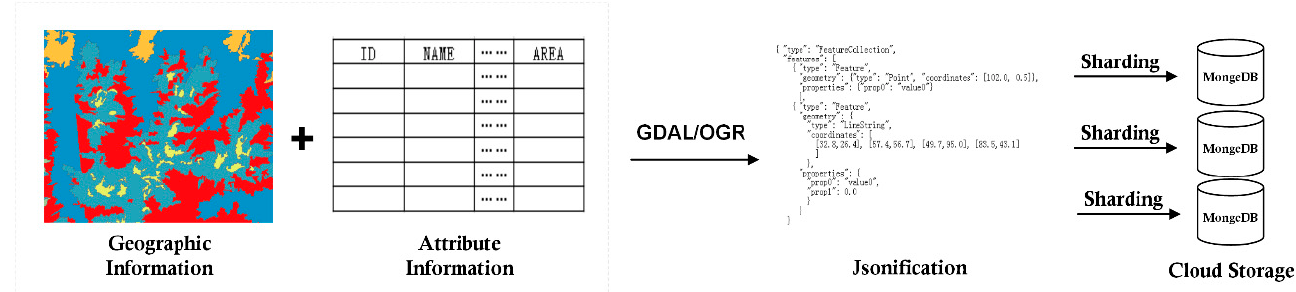
Figure 2. Architecture of the proposed SSMG method.